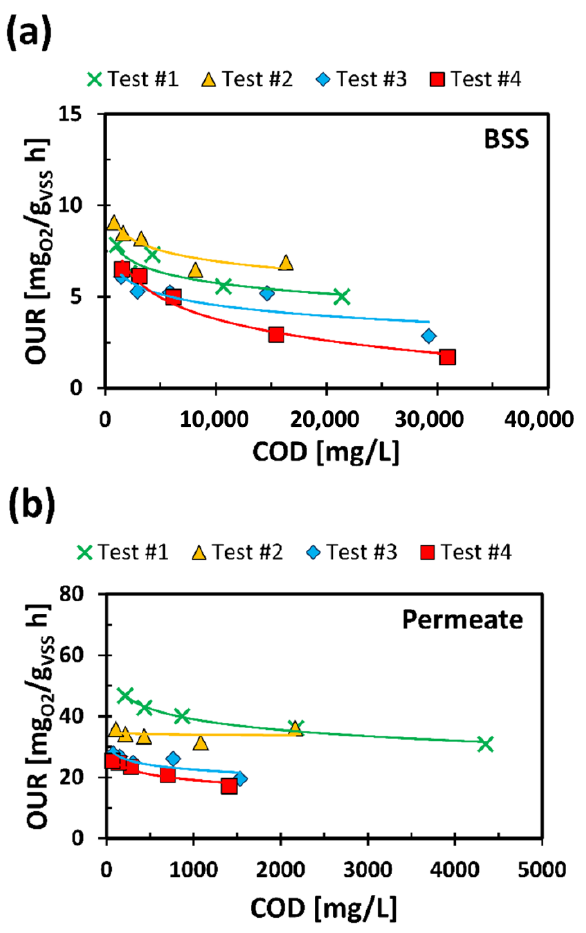
Figure 6. OUR trend with COD, for fed BSS ( a ) and permeate ( b ). Continuous lines represent the fitting of OR as a function of COD.